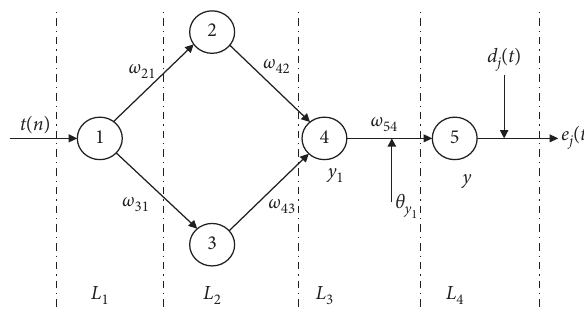
Figure 5: The prediction of gray neural